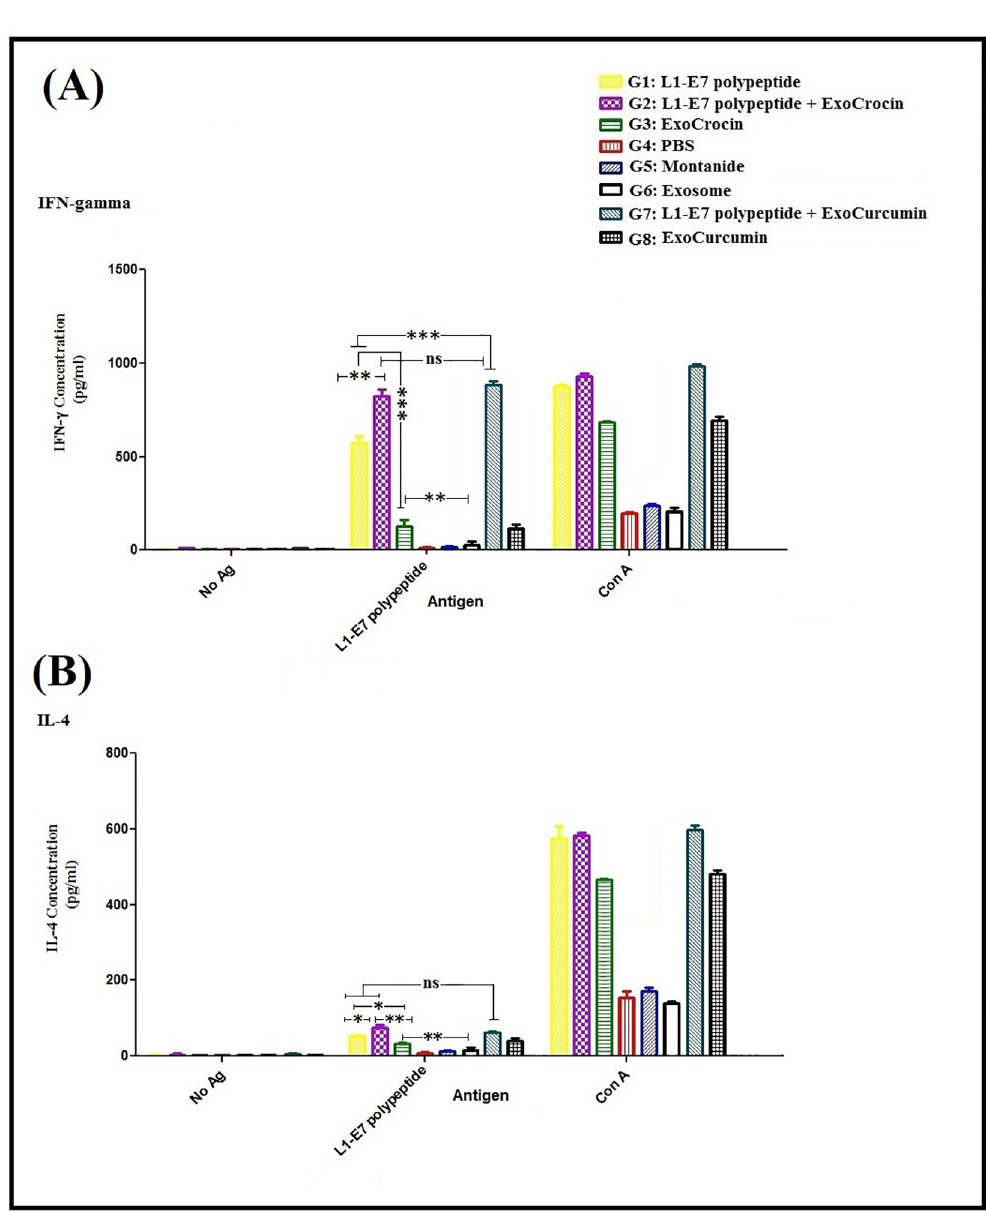
Fig 6. Evaluation of IFN- γ (A) and IL-4 (B) secretion in each group using sandwich ELISA: All analyses were performed in duplicate for each sample. The results were shown as mean absorbance at 450 nm ± SD. ns: non-significant; � p < 0.05; �� p < 0.01; ��� p <